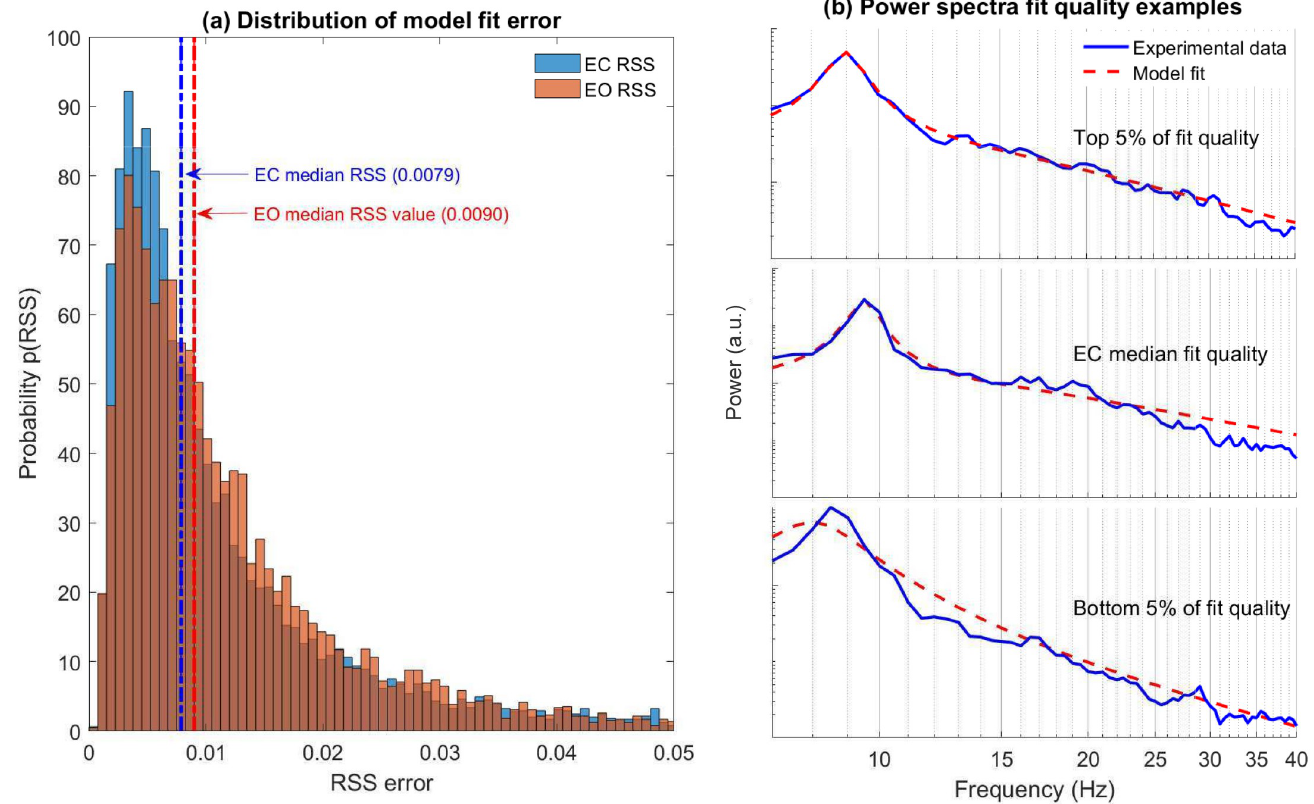
Fig 4. Resting EEG power spectral densities are well described by a sum of damped alpha oscillatory processes. (a) Histograms of the minimum residual sum of squares (RSS) error between experimental and model spectra for EC and EO states in pooled data set analysis. The median RSS error of EC = 0.0079 and EO = 0.0090 ( Δ median = − 0.0011, p = 10 − 6 ) are associated with objectively good fits. (b) Examples of model fit quality for three distinct cases. Plots are ordered top to bottom with decreasing fit error (EC spectra presented).